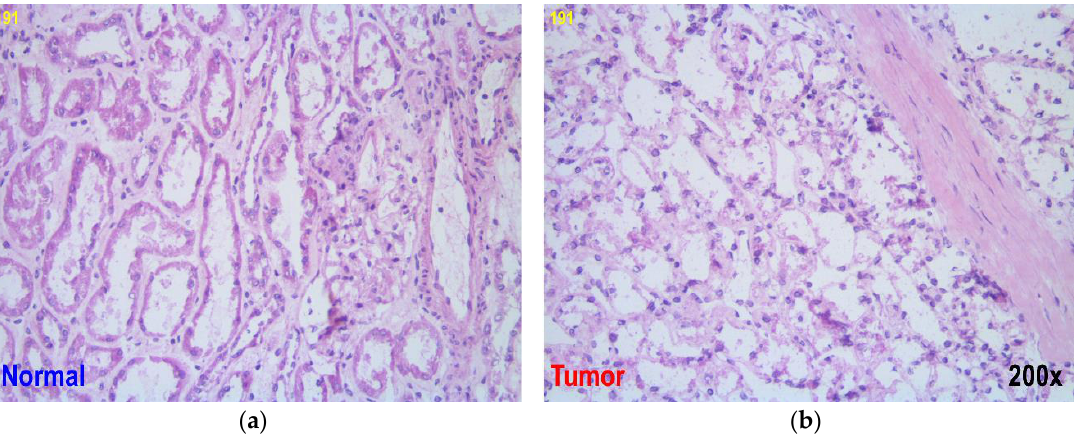
Figure 1. Biopsy microscope images of ( a ) normal and ( b ) kidney tumor tissue of patient 191 at 200× magnification.